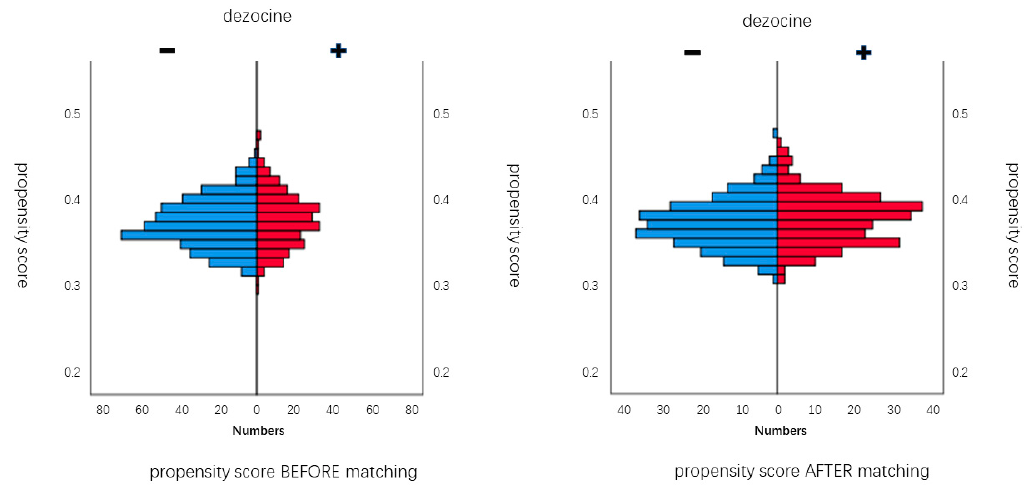
Figure 3. Histograms of propensity score distribution before and after propensity score matching. Distribution of the propensity scores before and after matching for the dezocine group (+) and the non-dezocine group ( − ). ( Left panel ) presents histograms of unbalanced propensity score distribution in both groups before propensity matching. ( Right panel ) presents histograms of balanced propensity score distribution in both groups after propensity matching.